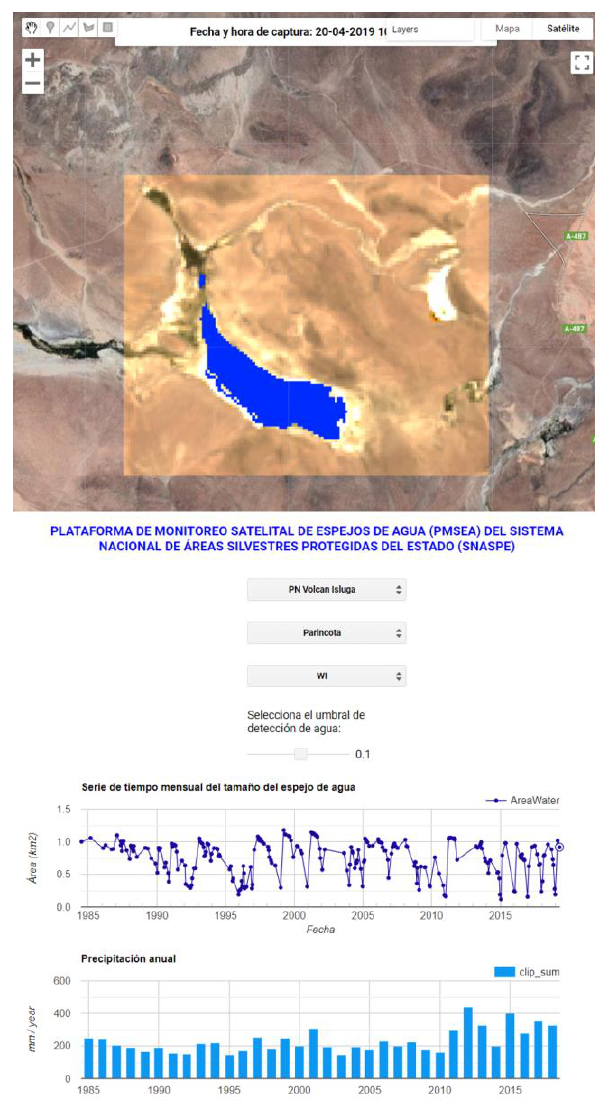
Figure 2. Surface Water Satellite Monitoring Platform of SNASPE.